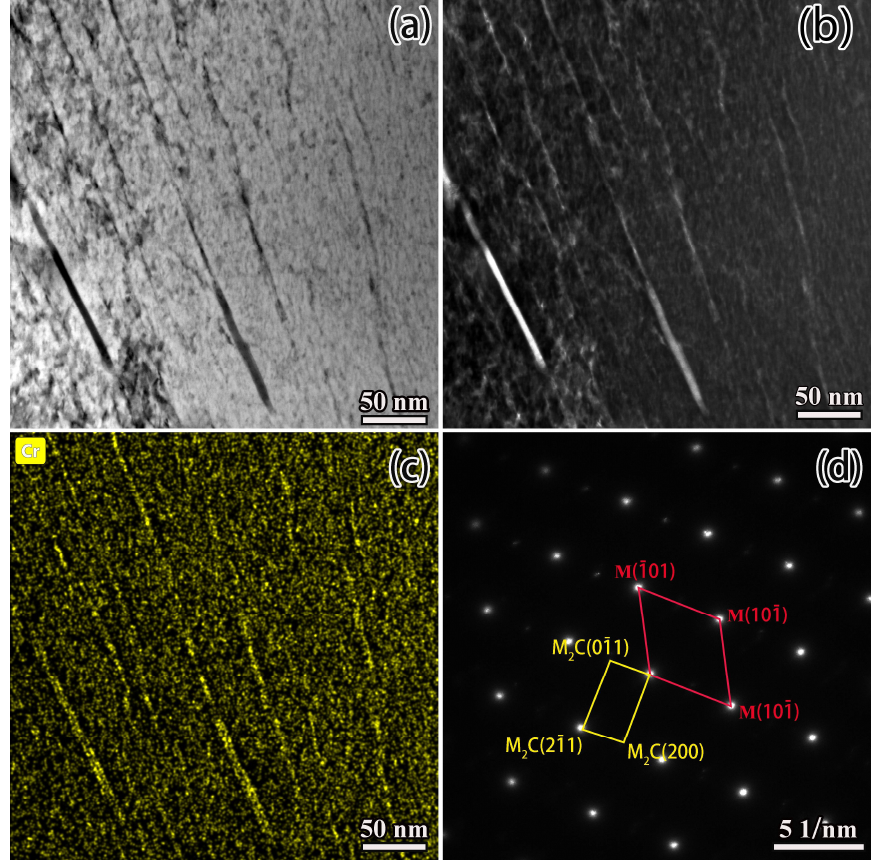
Figure 16. Carbides in 0.1 mm depth of carburizing layer for novel solid-solution carbu- rizing process: ( a , b ) bright- and dark-field image of carbides; ( c ) Cr elemental mapping analysis; ( d ) calibration of ( a ).